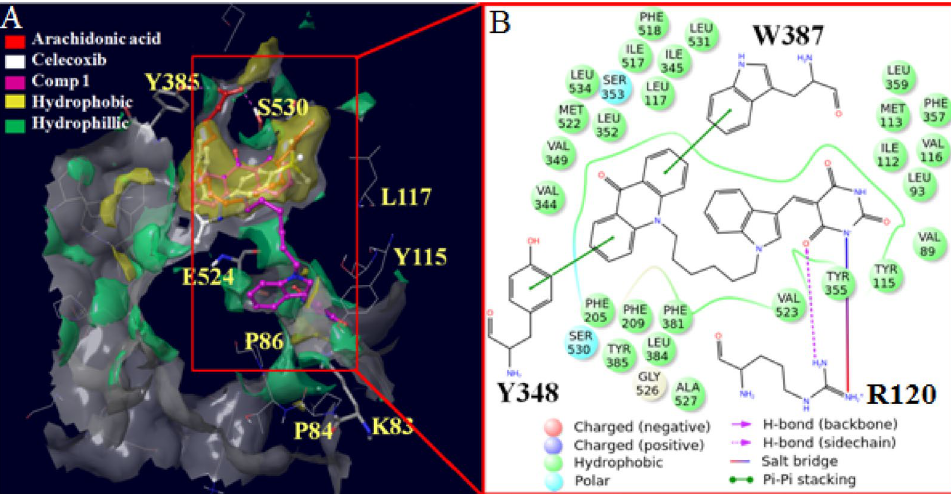
Figure 6. ( A ) Solid surface top view of the arachidonic acid binding pocket (site 1) and allosteric site (site 2) of COX-2 in association with 1 (pink). For site 1, the yellow part represents hydrophobic region whereas green